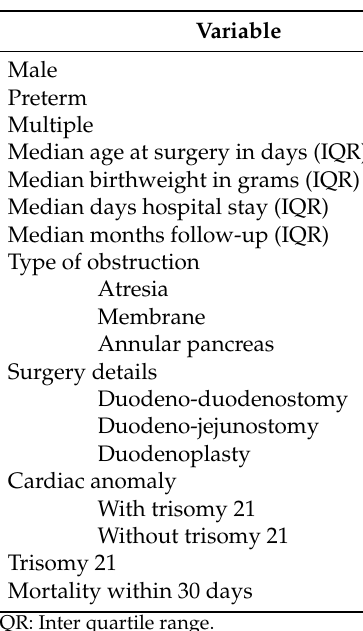
Table 1. Patient